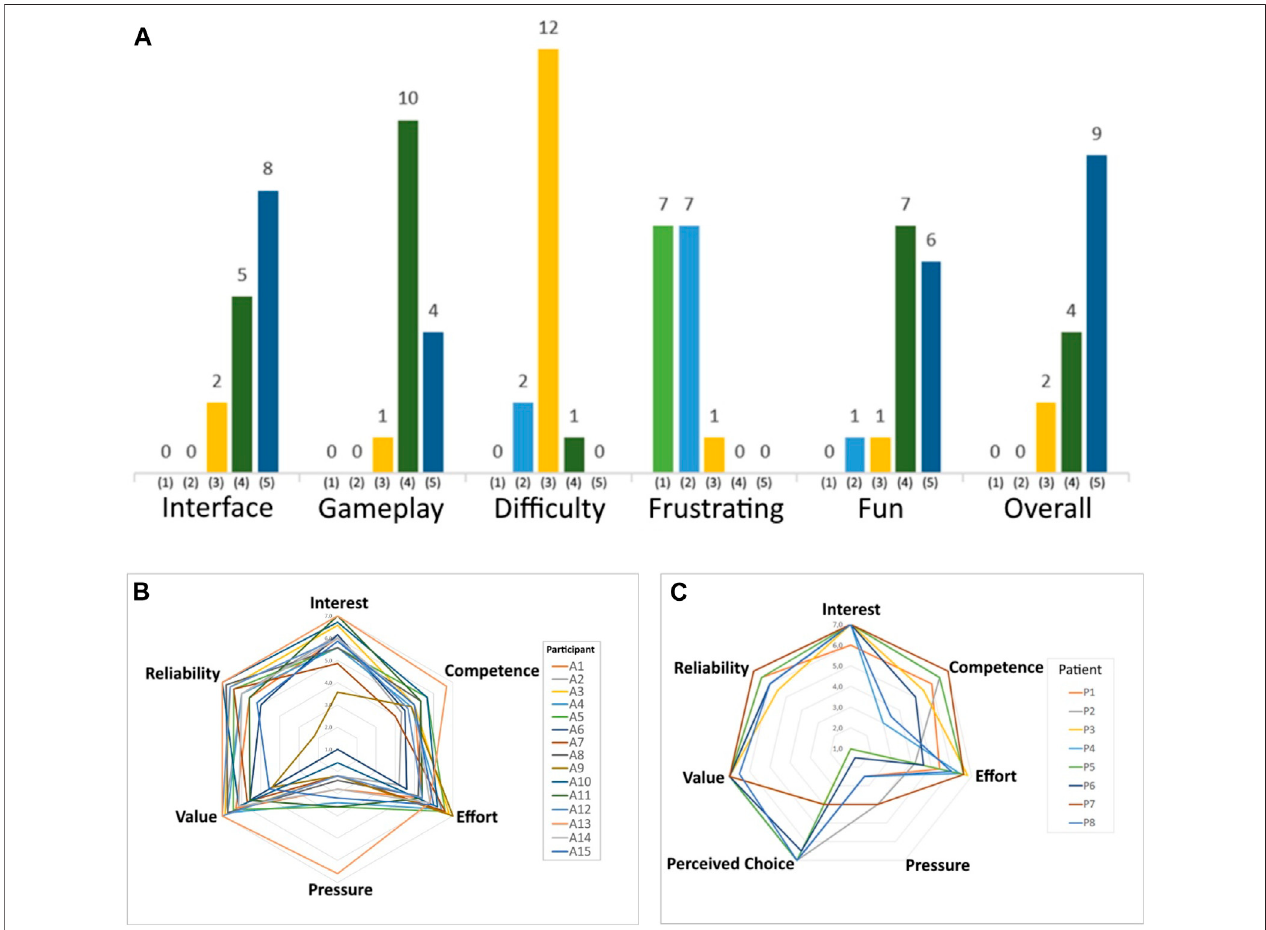
FIGURE 12 | Questionnaires applied (indices in each category): (A) GEQ for healthy subjects, Intrinsic Motivation Inventory for (B) healthy subjects and (C) post- stroke patients.